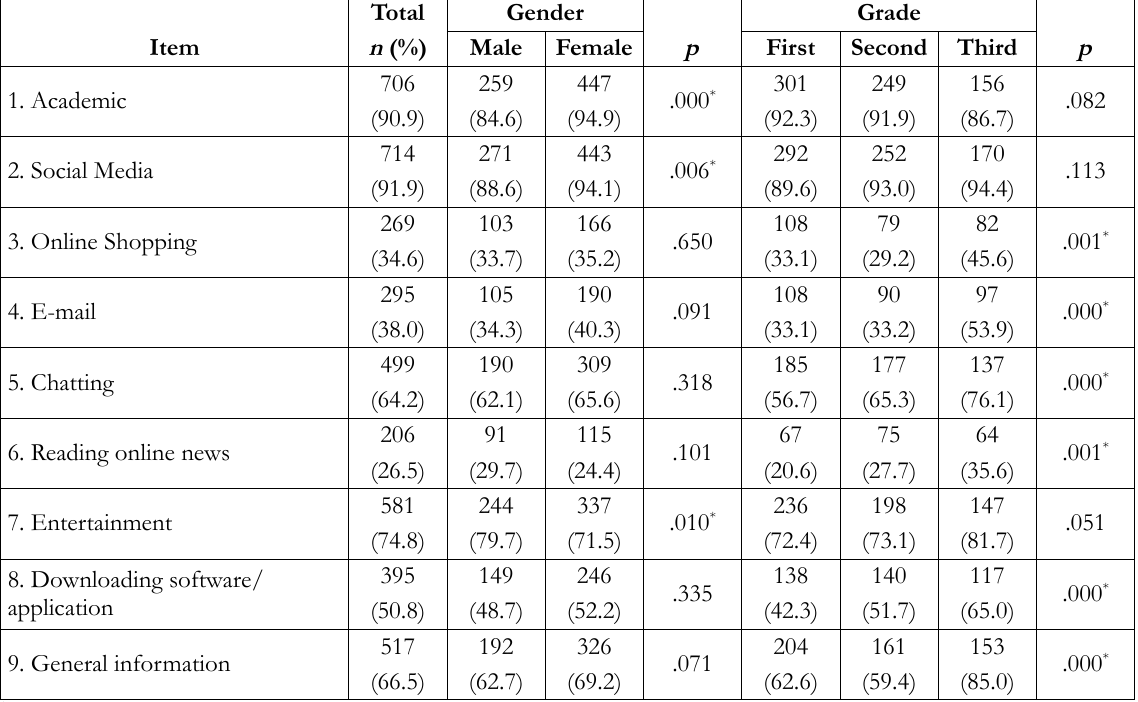
Table 3. General purpose of students’ internet